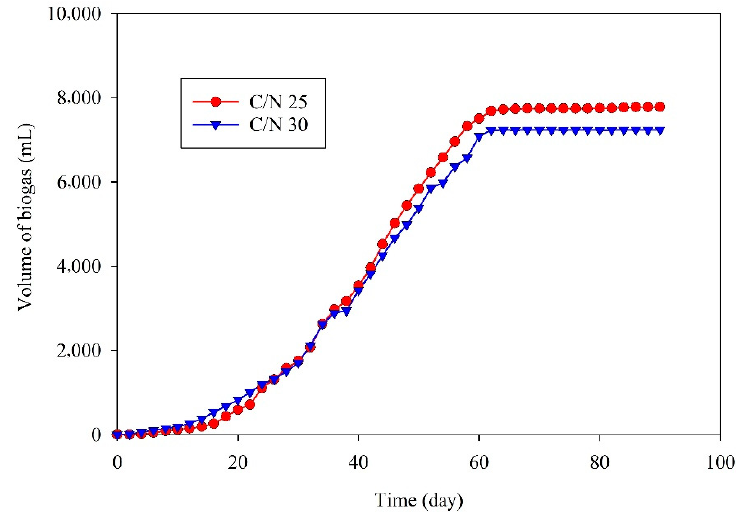
Figure 9. Effect of different C/N ratios on the accumulation of 25% total solids (TS) biogas non- delignification.